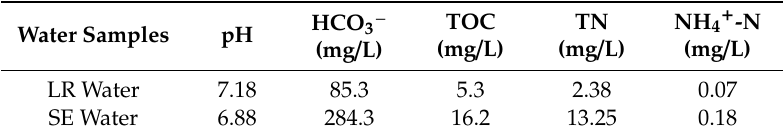
Table 2. Characteristics of LR Water and SE